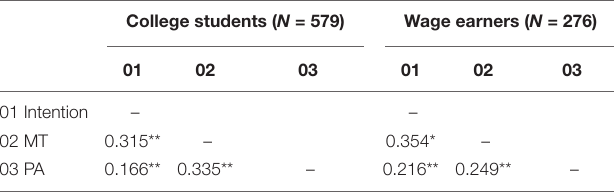
TABLE 3 | Correlations between intention, mental toughness (MT) and physical activity